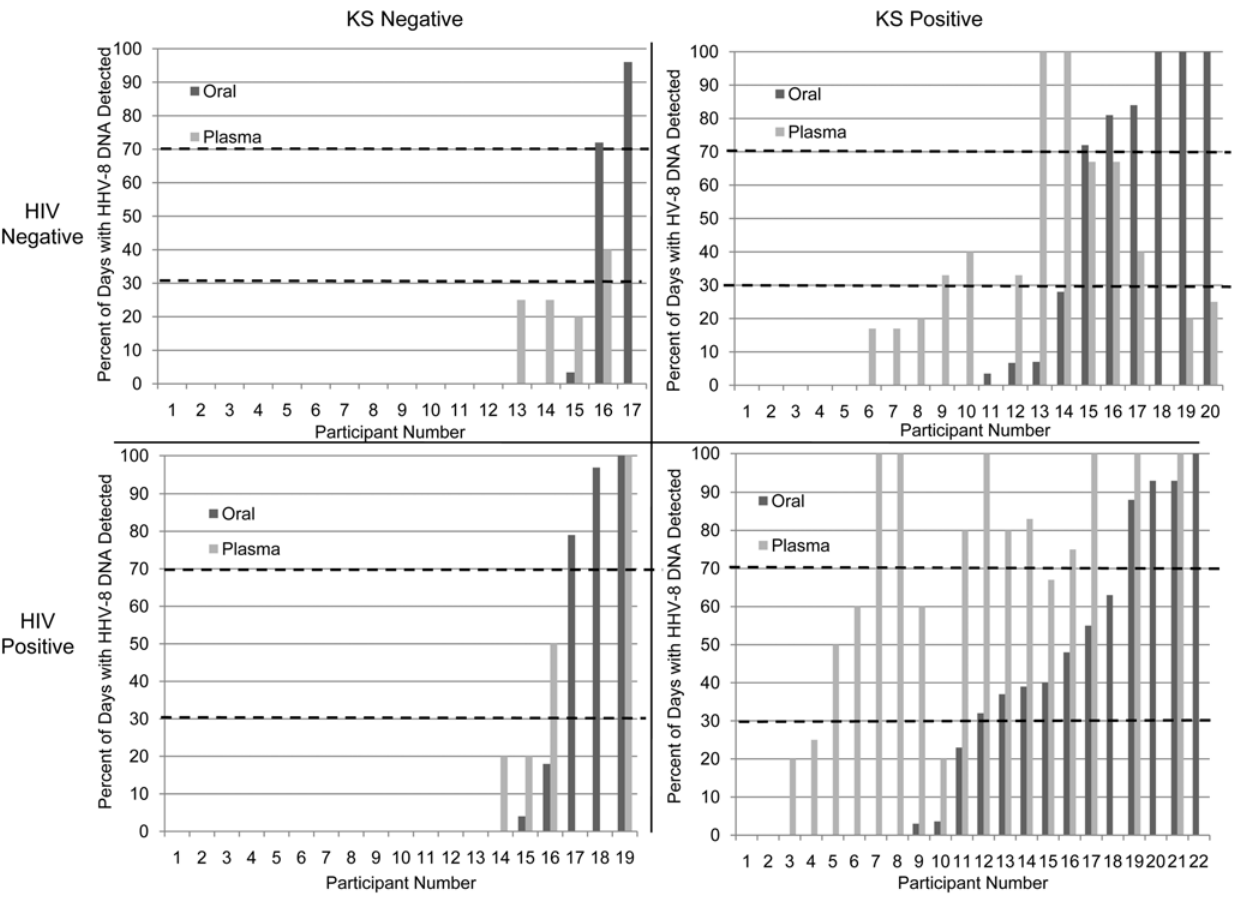
Figure 4. Rate of HHV-8 detection from oral swabs and plasma samples in individual participants, by HIV and KS status. Participants are numbered in ascending order according to oral shedding rate in each group. The participants collected a median of 29 oral swabs, 4 genital swabs, and 5 plasma samples per person.